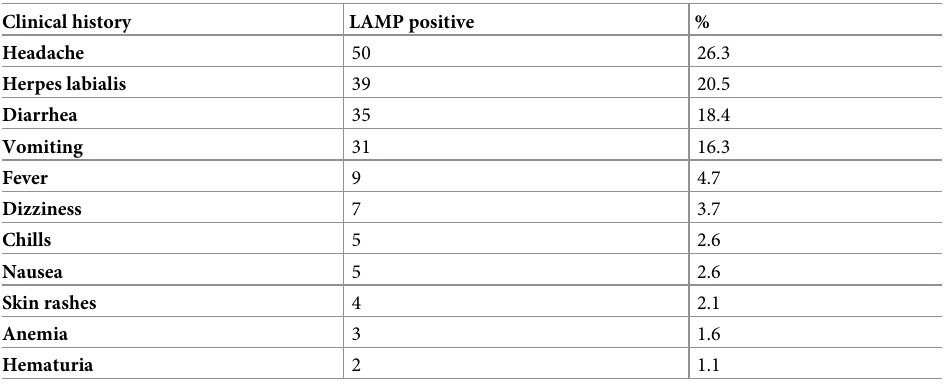
Table 3. The proportions of the clinical features of the LAMP positive